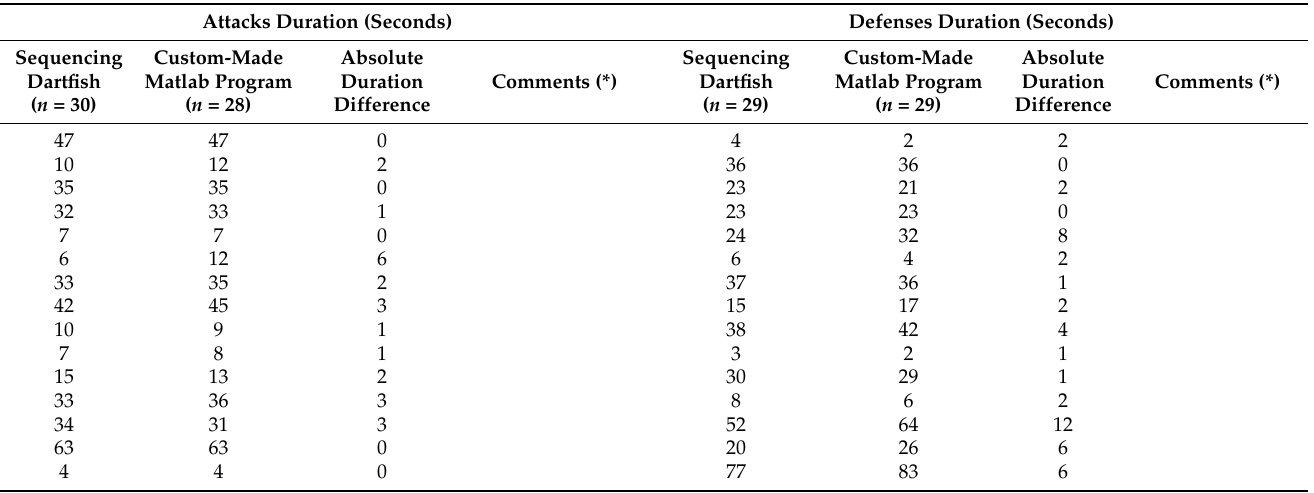
Table A3. First half of the second match of the data validation set. Comparisons between Dartfish sequencing and the custom-made Matlab